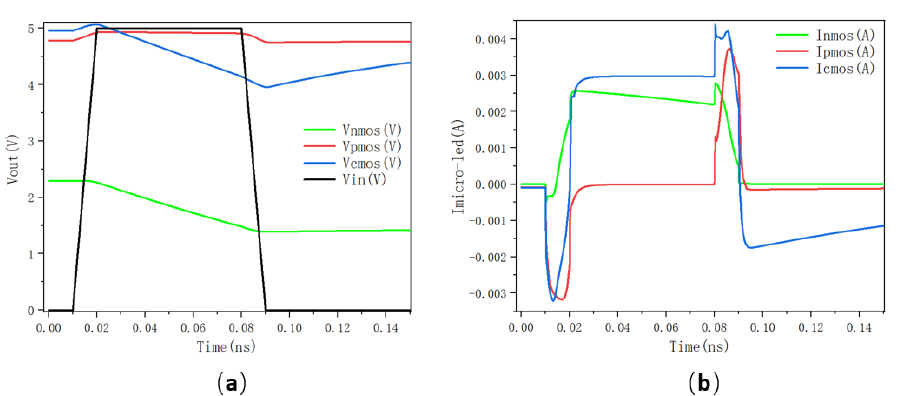
Figure 12. ( a ) Output voltage-time curve; ( b ) Output current-time curve.